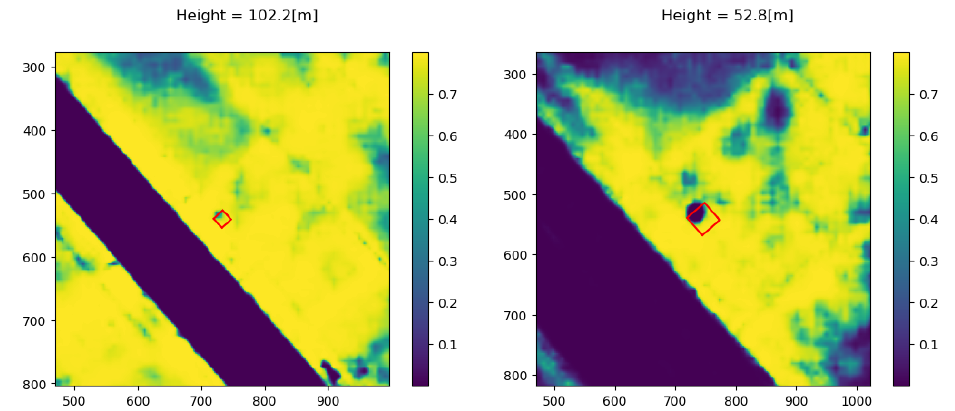
Figure 13. Semantic segmentation output: telephone booth partially occupies the cell.